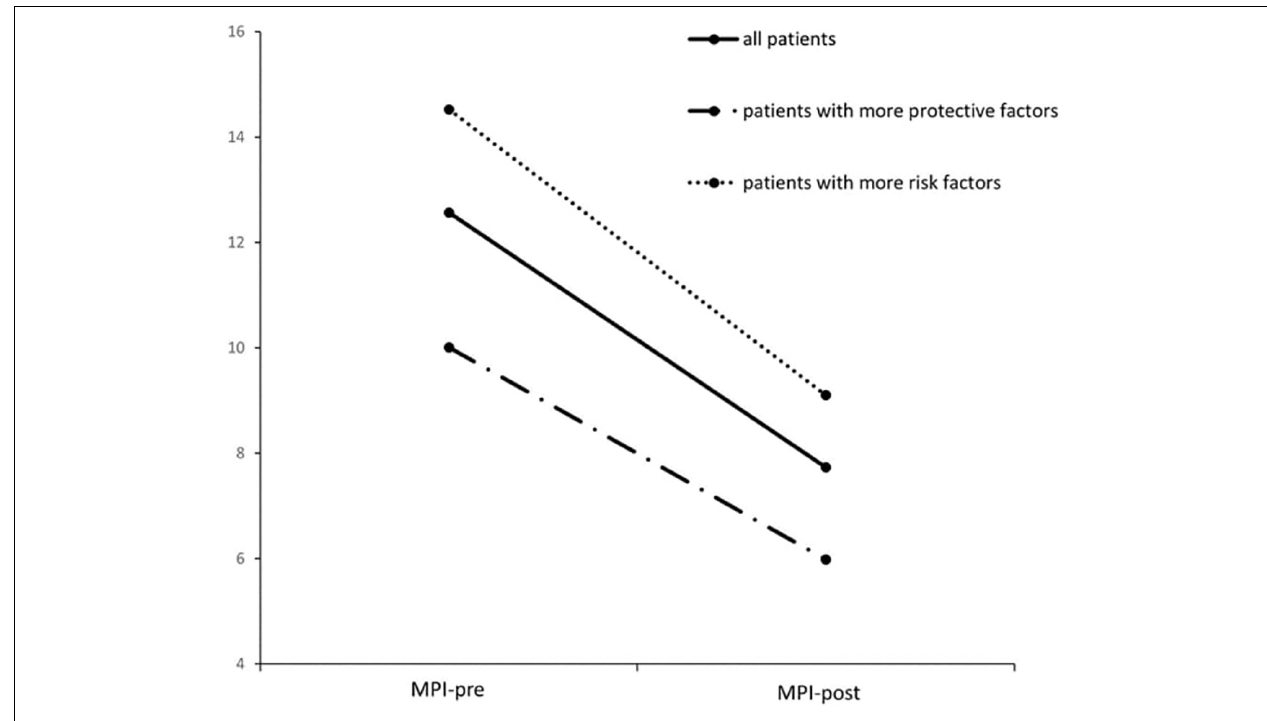
FIGURE 2 | Risk and protective factors and their relationship to child psychiatric